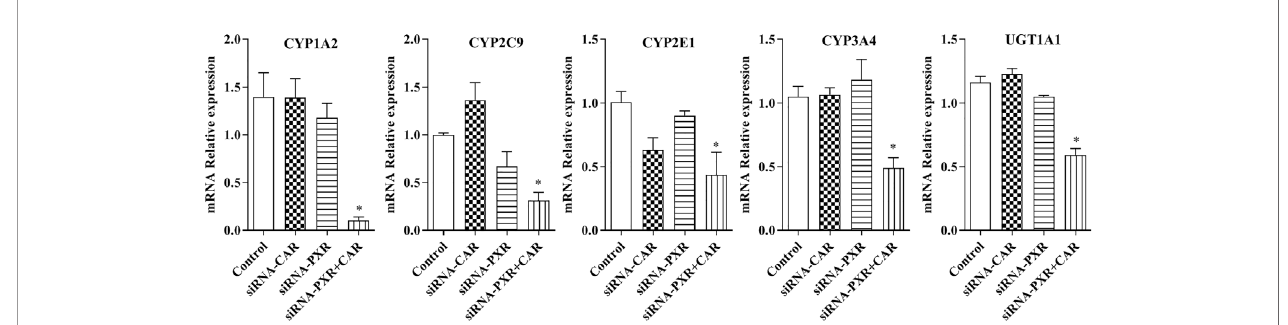
FIGURE 8 | mRNA expression of CYP1A2, CYP2C9, CYP2E1, CYP3A4, and UGT1A1 after treatment with siRNA-PXR and siRNA-CAR. Following transfection with the siRNA-PXR and siRNA-CAR vectors, HepG2 cells were incubated for 24 h under normoxia. The data were analyzed using a one-way analysis of variance (ANOVA), and the differences between the means of two groups were compared using LSD tests. * indicates the signi fi cance of experimental groups, compared with that of the control. Values were expressed as Mean ± SEM (n = 3). Levels are considered signi fi cant at * p < 0.05.